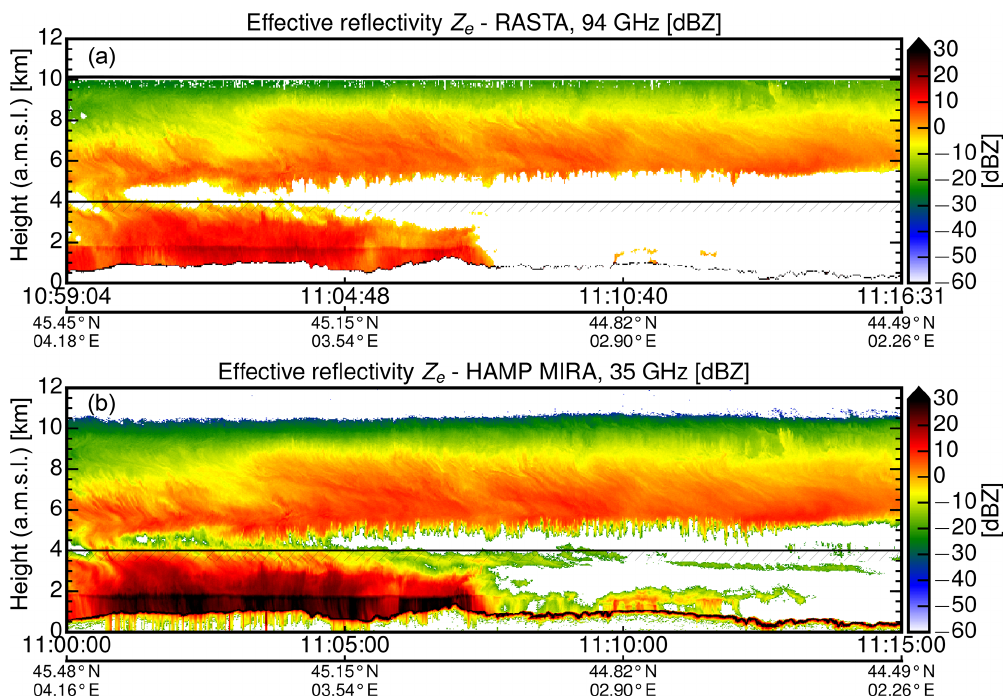
Figure 12. Radar measurements performed with RASTA at 94GHz (a) and HAMP MIRA at 35GHz (b) along the coordinated flight track marked in Fig. 11. The reflectivity of HAMP MIRA was calculated using the new calibration. Cloud parts below 4km (hatched line) were discarded in the direct comparison of Z e values in Fig. 13a to exclude effects caused by different attenuation or scattering regimes. The thin black line between 0.5 and 1.5km shows the ground return of the Massif Central.